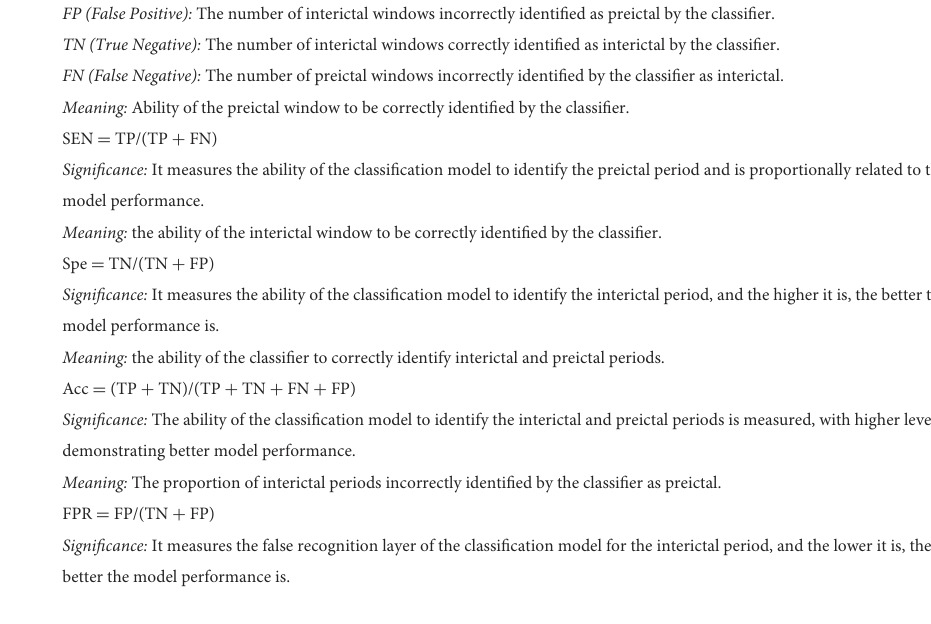
TABLE 1 Evaluation metrics for “segment-based” and “event-based” models for predicting seizures. “segment-based”